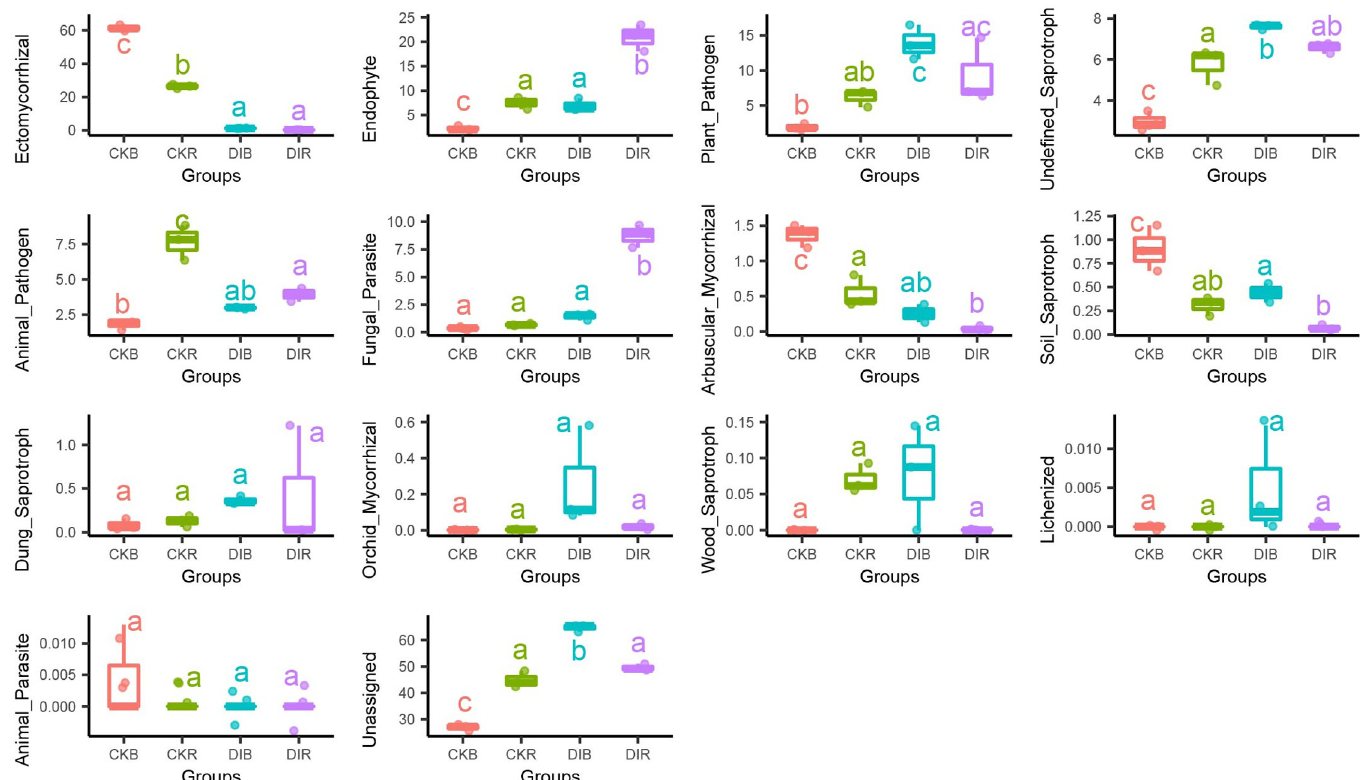
Fig 6. Functional analysis of soil fungi using FUNGuild. Data on the y-axis represent the relative abundance (%).